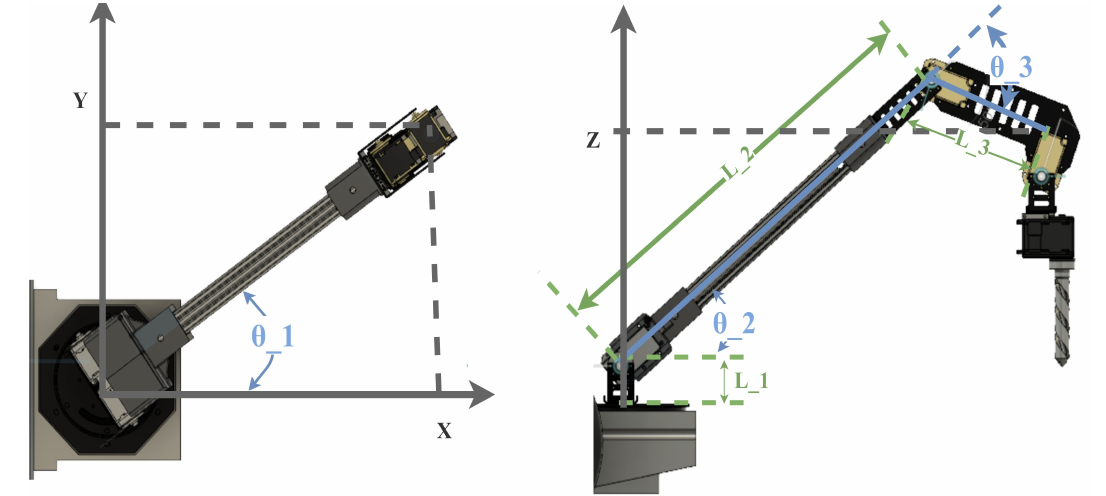
Figure 9. Geometric relationships for inverse